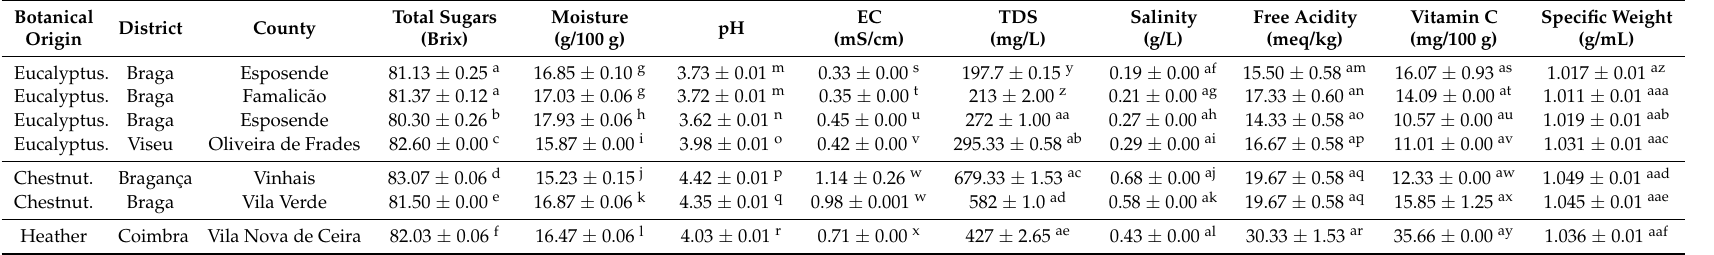
Table 2. Physicochemical parameters of Portuguese honeys according to botanical and geographical